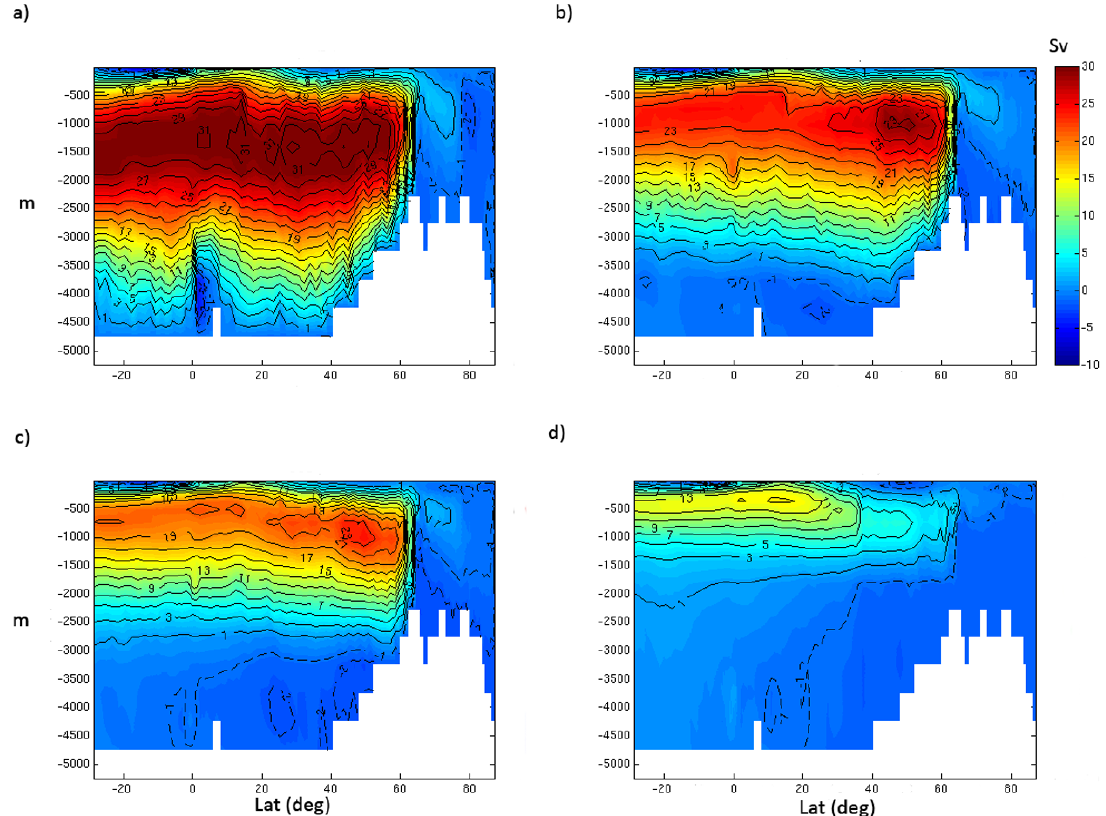
, (c) 8CO and (d) 16CO 2 2 2